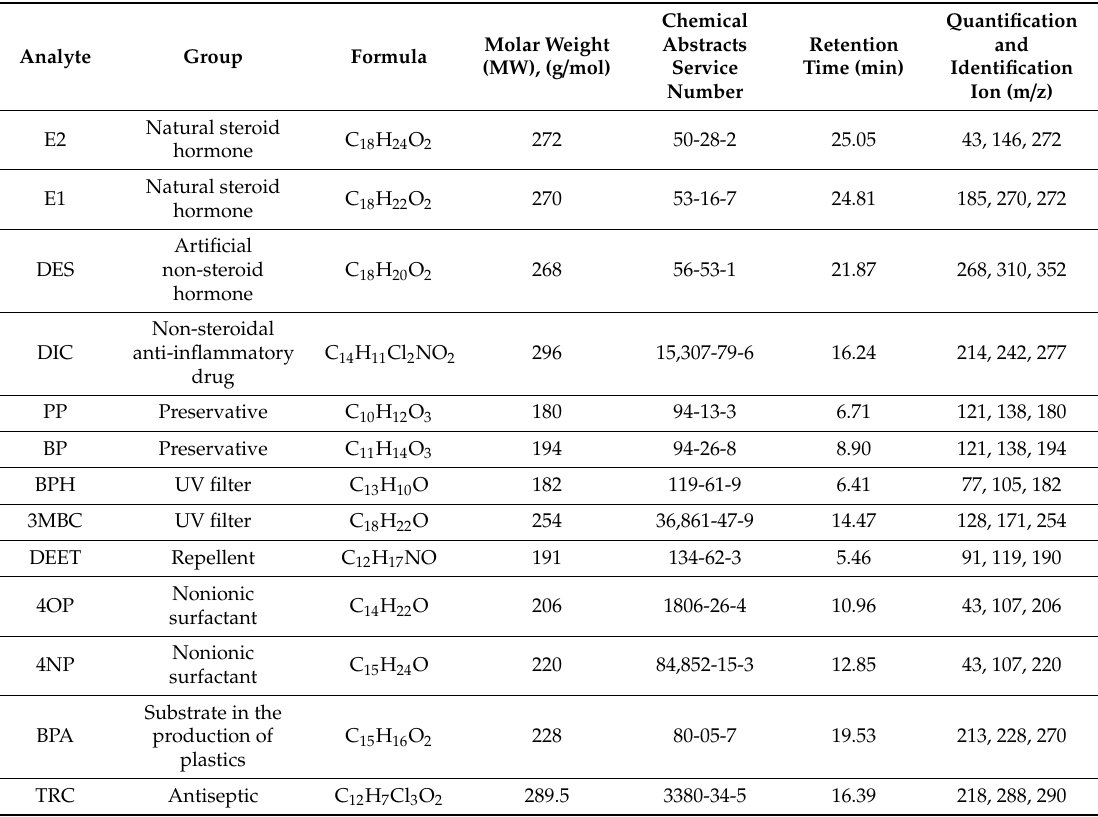
Figure 2. Chromatogram obtained during the GC-MS analysis: (1) N,N-diethyltoluamide (DEET), (2) benzophenone (BPH), (3) propylparaben (PP), (4) butylparaben (BP), (5) 4-t-octylphenol (4OP),(6) 4-n-nonylphenol (4NP), (7) 3-(4-methylbenzylidene)camphor (3MBC), (8) diclofenac (DIC), (9) triclosan (TRC) (10) tricosane (internal standard), (11) bisphenol A (BPA), (12) diethylstilbestrol (DES), (13) estrone (E1), (14) β -estradiol (E2). Table 1. Retention times, molecular weights of target compounds, together with quantification and identification ions.